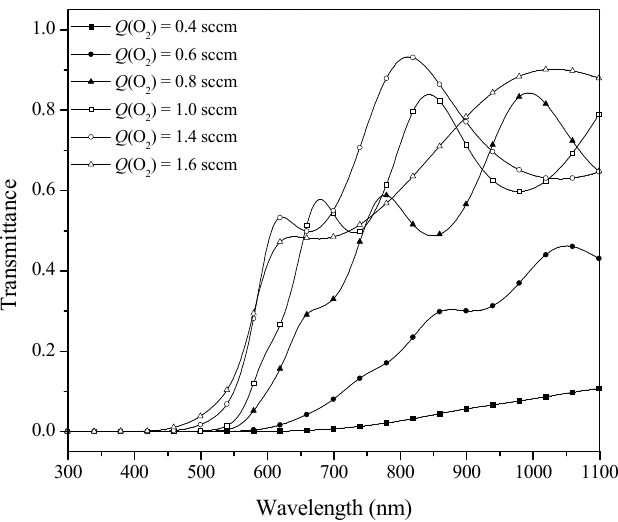
Figure 7. Influence of the oxygen flow rate on the transmittance of Fe-O-N films ( Q (N 2 ) = 8 sccm).